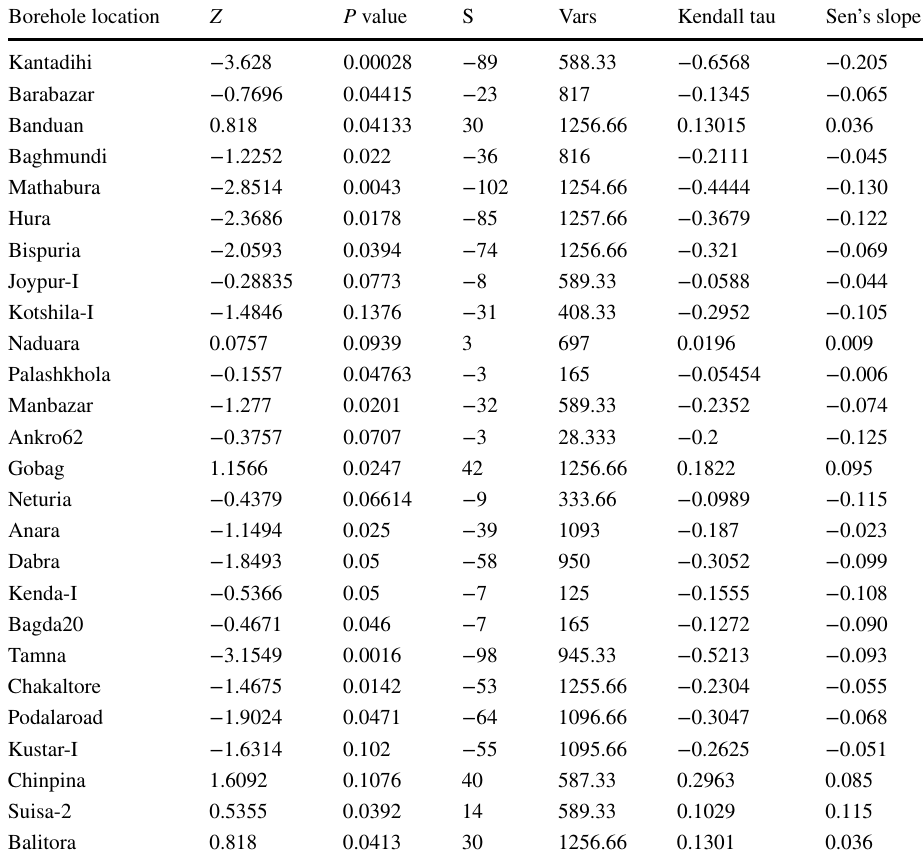
Table 2 Result of Mann– Kendall trend test on pre- monsoon groundwater table